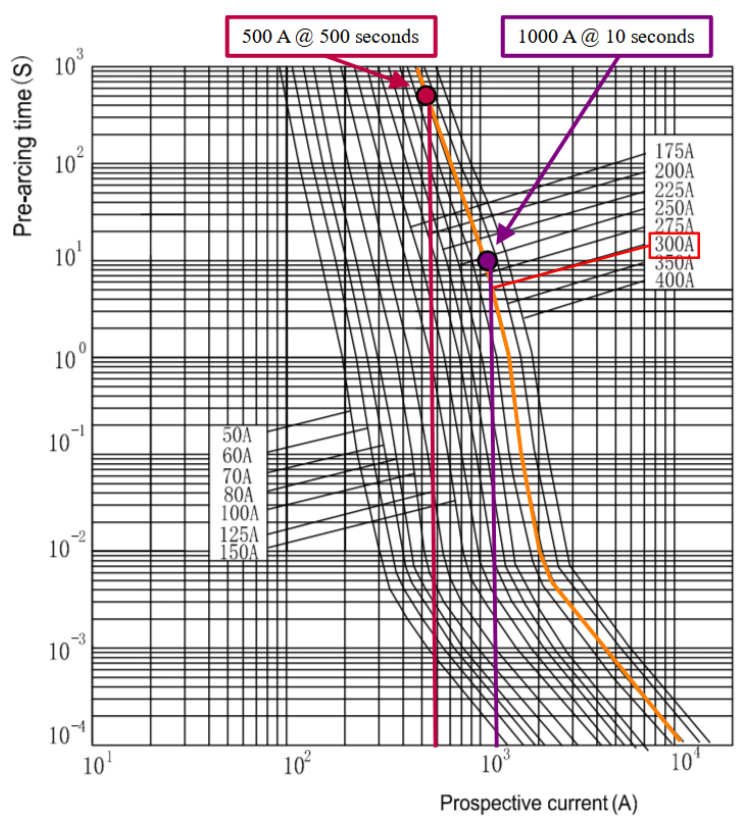
Figure 16. Curve current vs time of 300 A